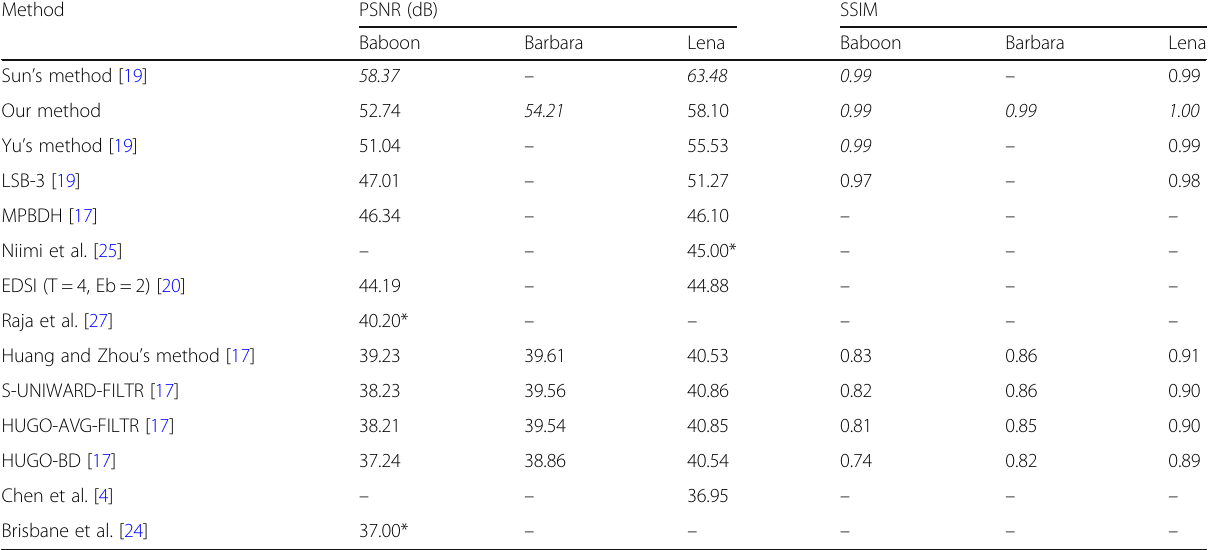
Table 1 Quality comparison results of different steganography methods